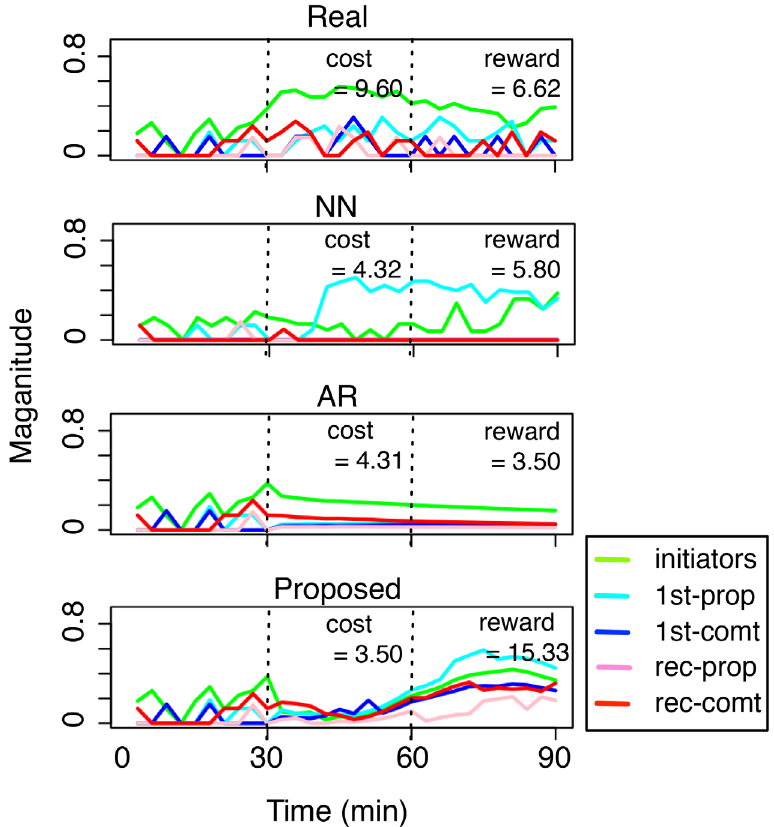
Fig 9. Case study: real versus the suggested dynamics using different methods. A good solution is characterized by low cost (during t 2 [30, 60]) and high reward (during t 2 [60, 90]). The X-axis denotes time (in minutes) and the Y-axis denotes the normalized number of different types of